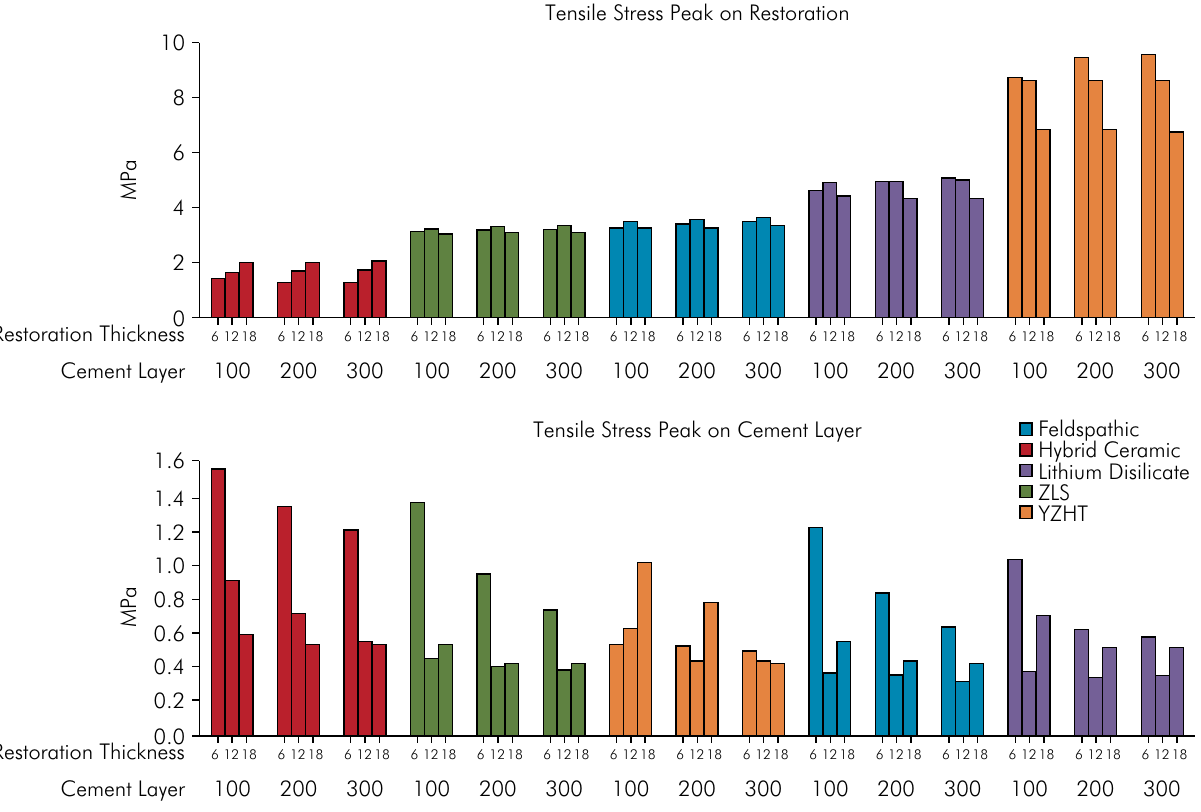
Figure 5. Bar graph of stress peaks generated in cement and restoration for all 45